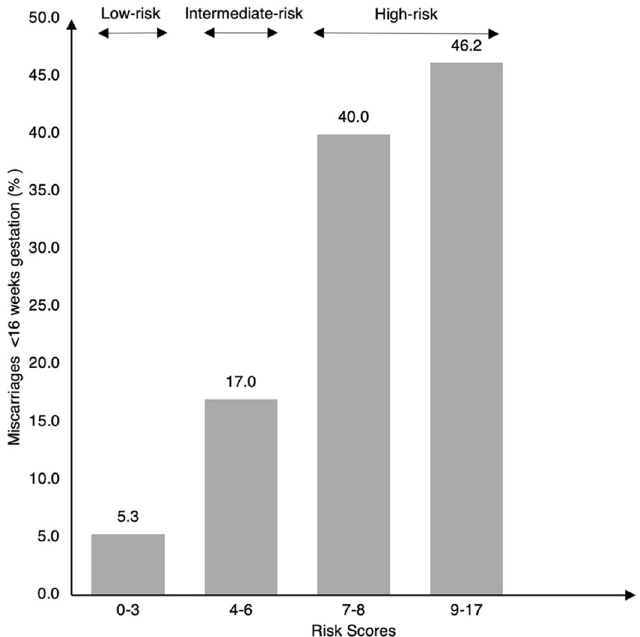
Figure 2. Proportion of women with miscarriages < 16 weeks gestation according to the risk scores (P-for- trend < 0.001). Scores 0–3 (< 10% miscarriage): low-risk; scores 4–6 (10 to < 40% miscarriage): intermediate-risk; scores 7–17 (≥ 40% miscarriage): high-risk.